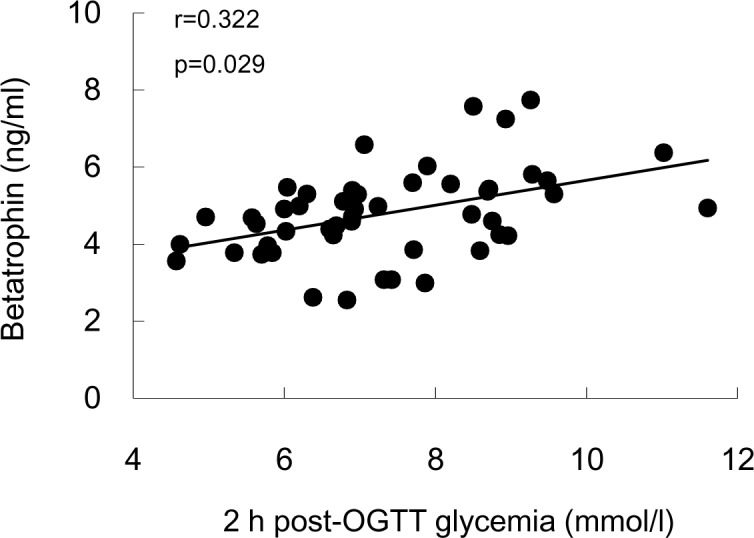
Correlation analysis between maternal gestational OGTT glycemia and cord blood betatrophin.Correlation was adjusted for pregestational BMI, gestational weight gain, cord blood HOMA-IR, newborn birth weight, sex, parity, and gestational age at delivery and maternal age. Data represents both cohorts (n = 54).